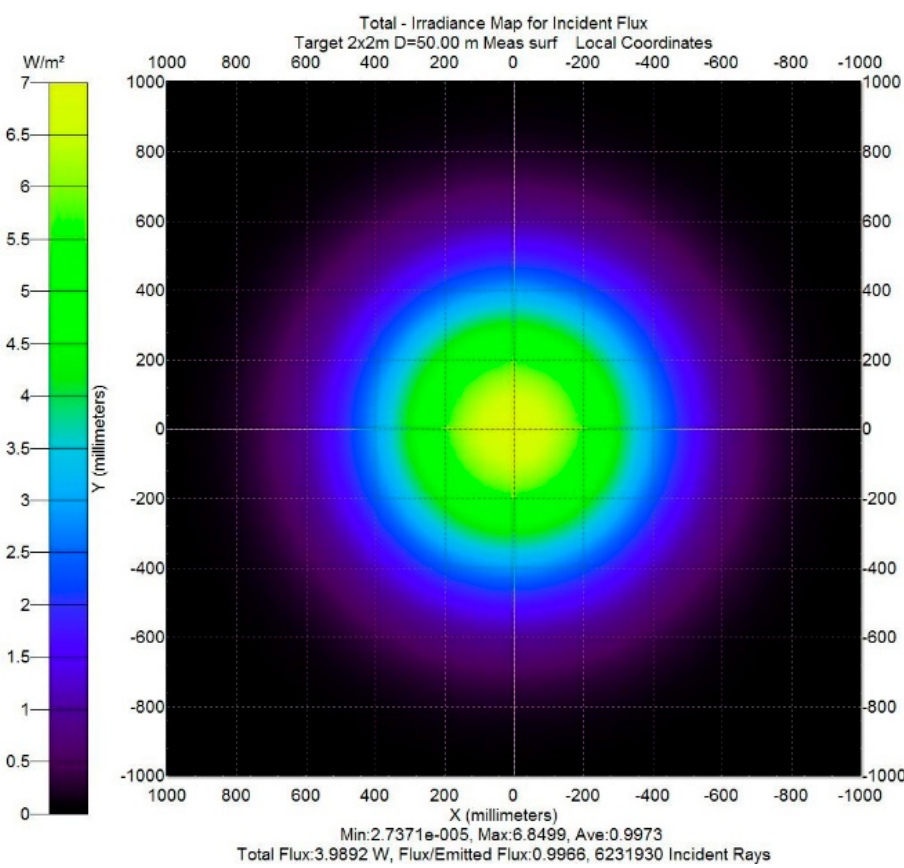
Figure 10. Simulated irradiance map on the target for 2 L F = 2 m with 8 × 8 facets.